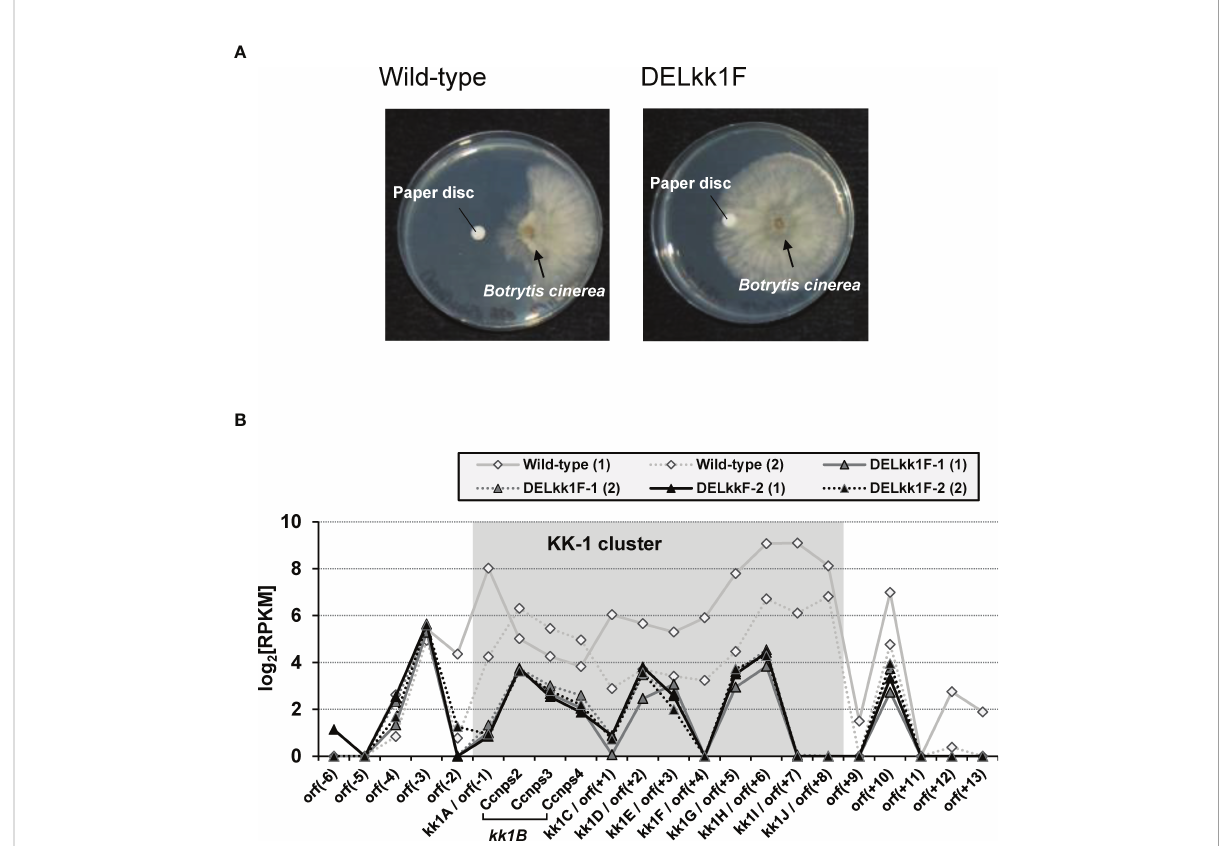
FIGURE 8 Analysis of the kk1F deletion strain. (A) Biological assays of the antifungal activity in the culture supernatants of the wild-type and kk1F deletion strains (DELkk1F). The pictures show the Botrytis cinerea colonies grown against paper discs soaked with the culture supernatant of each strain. (B) The reads per kilobase of exon per million mapped reads (RPKM) expression values in log2 scale for the putative KK-1 biosynthetic gene cluster corresponding to the gene IDs from kk1A to kk1J that are shown as shading and the surrounding genes of the wild-type and two kk1F deletion strains (DELkk1F-1, DELkk1F-2) on day 3 of the culture. The numbers (1) and (2) indicate biological replicates. The region containing Ccnps2 , Ccnps3 , and Ccnps4 corresponds to kk1B , which encodes non-ribosomal peptide